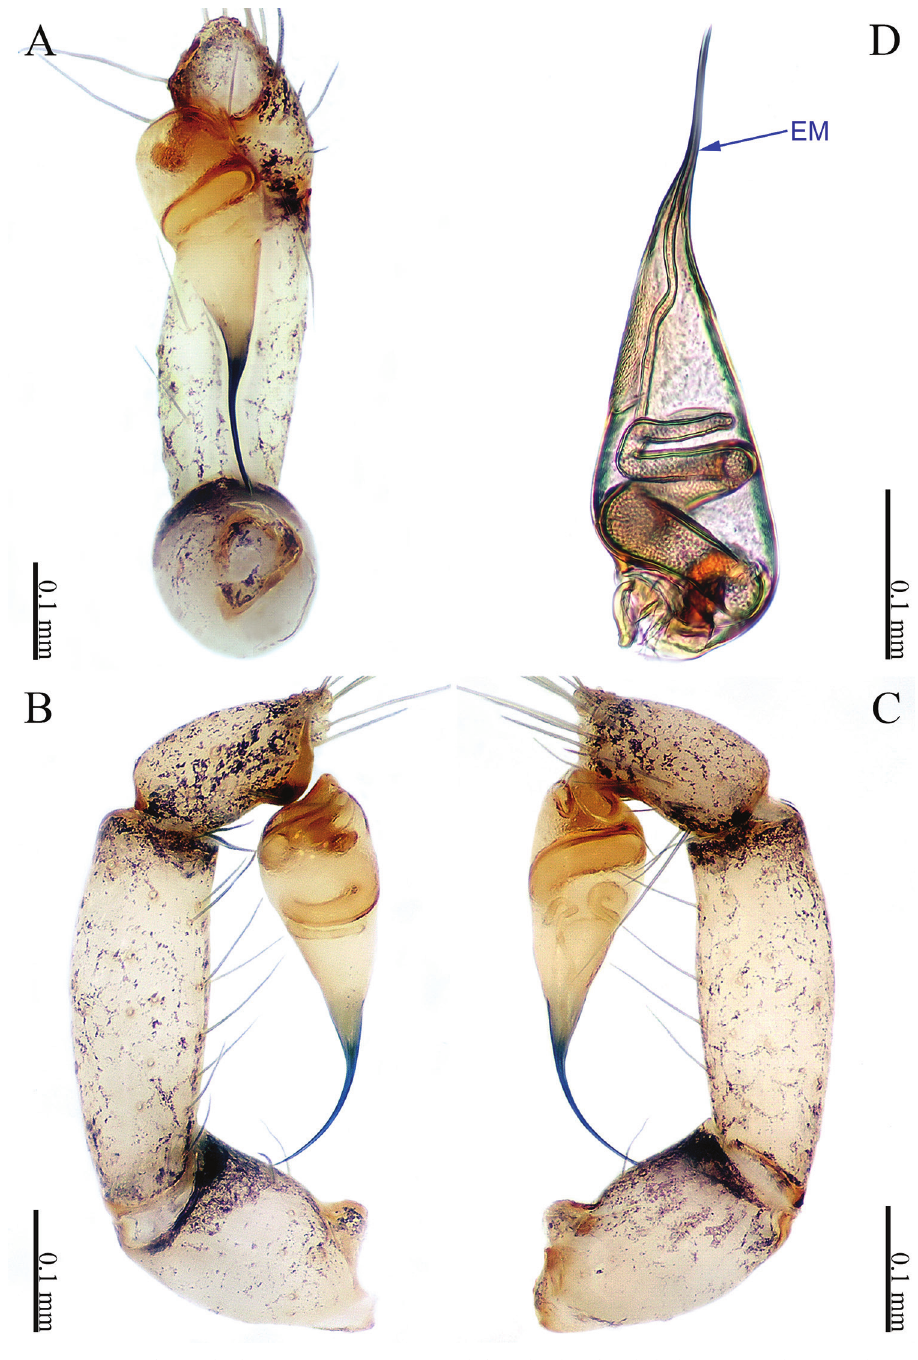
Figure 5. Sinoderces phathaoensis Li & Li, sp. nov., left pedipalp of male holotype A palp, ventral view B palp, prolateral view C palp, retrolateral view D palpal bulb, ventral view. Abbreviation: EM